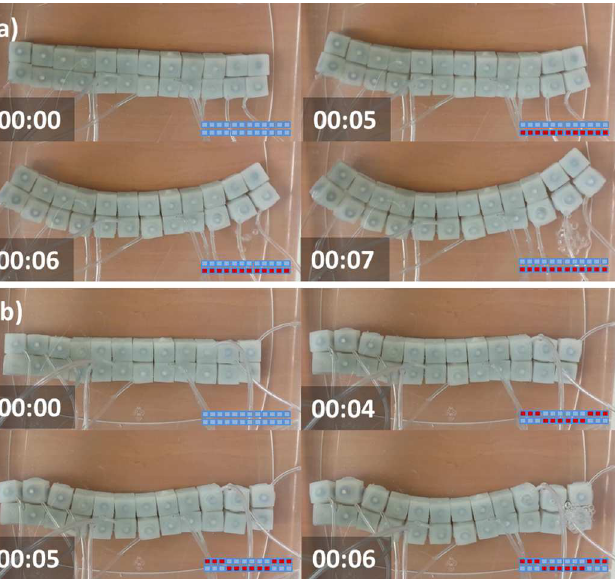
Fig 8. Cell invagination. Underwaterexperiments using a rectangularbeam assembledusing 24 soft modularrobots. a) Transition from rectangular to curved shape. b) Transition from rectangularto double inflectioncurvature. Inflation patterns are displayedon a lower box using red for inflatedmodulesand light blue for unactuated modules.Time stamps are in the format